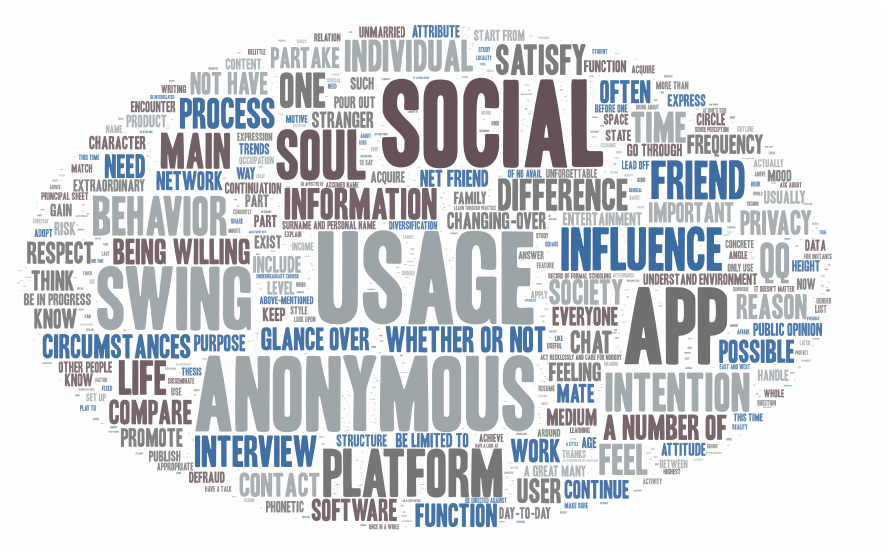
Figure 1. Word Cloud Map.